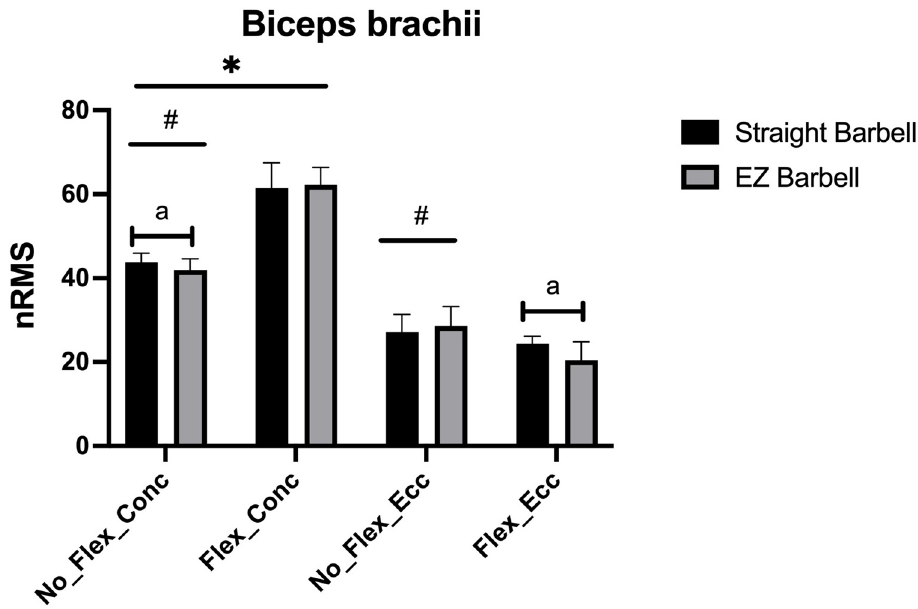
Figure 4. The nRMS for the biceps brachii is shown. a: p < 0.05 vs. the EZ barbell; #: p < 0.05 vs. flexing the arms; *: p < 0.05 vs. the descending phase.